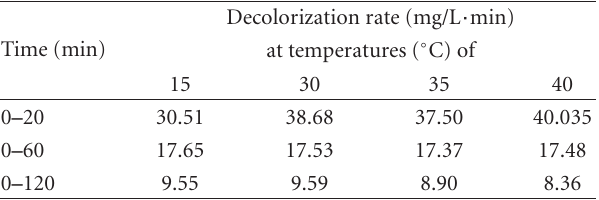
Table 2: Decolorization rate (mg/L · min) at di ff erent temperatures at [MG] 0 = 15mg/L, [Glucose] 0 = 1g/L, [enzyme] 0 = 1000 U/L and [Fe 2+ ] 0 =